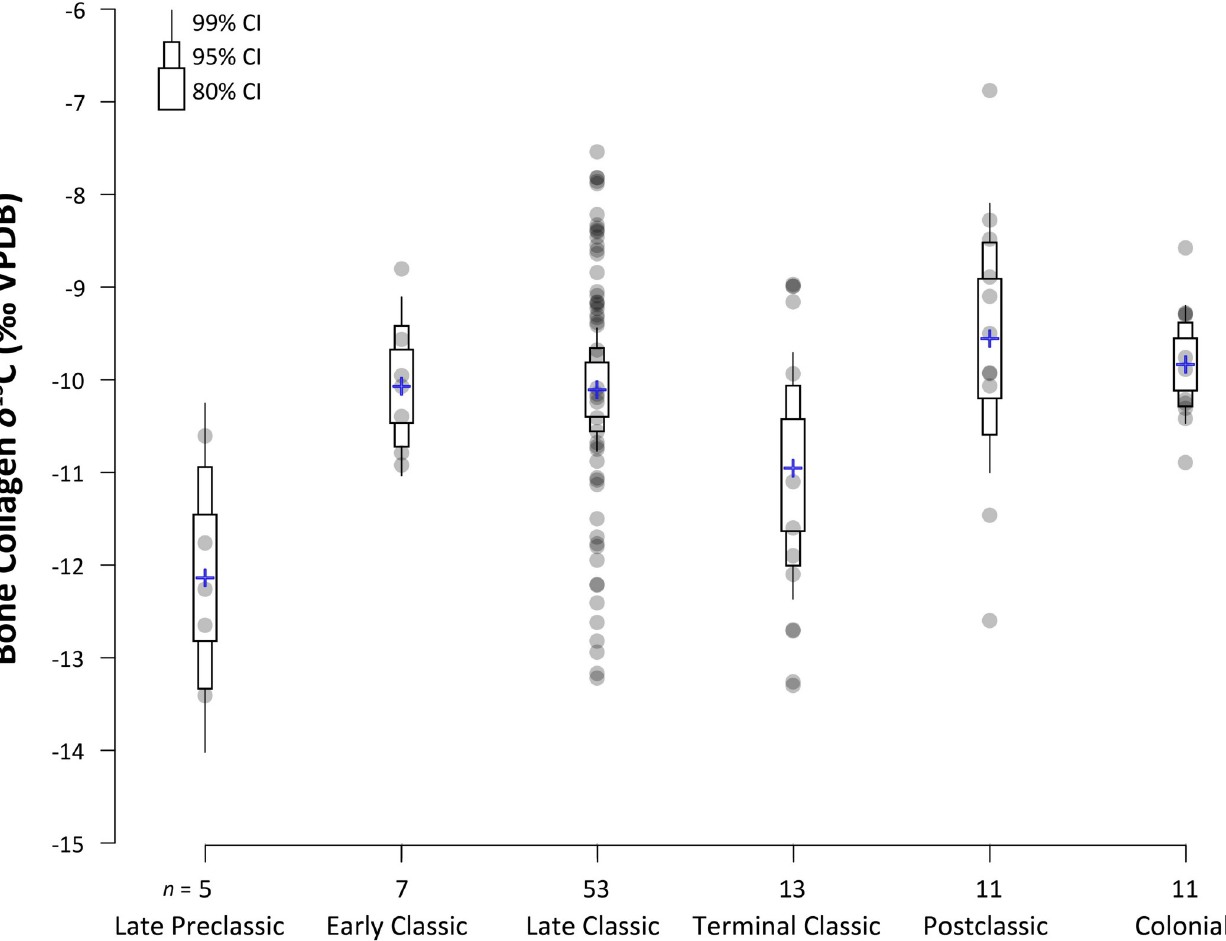
Fig 4. Bullet graph of stable carbon ( δ 13 C) isotope values for human bone collagen. Data points are shown as circles with the means for each time period indicated by a cross. The bullet graph shows the 80%, 95%, and 99% confidence intervals (CIs; thickest to thinnest bullets) around the mean.